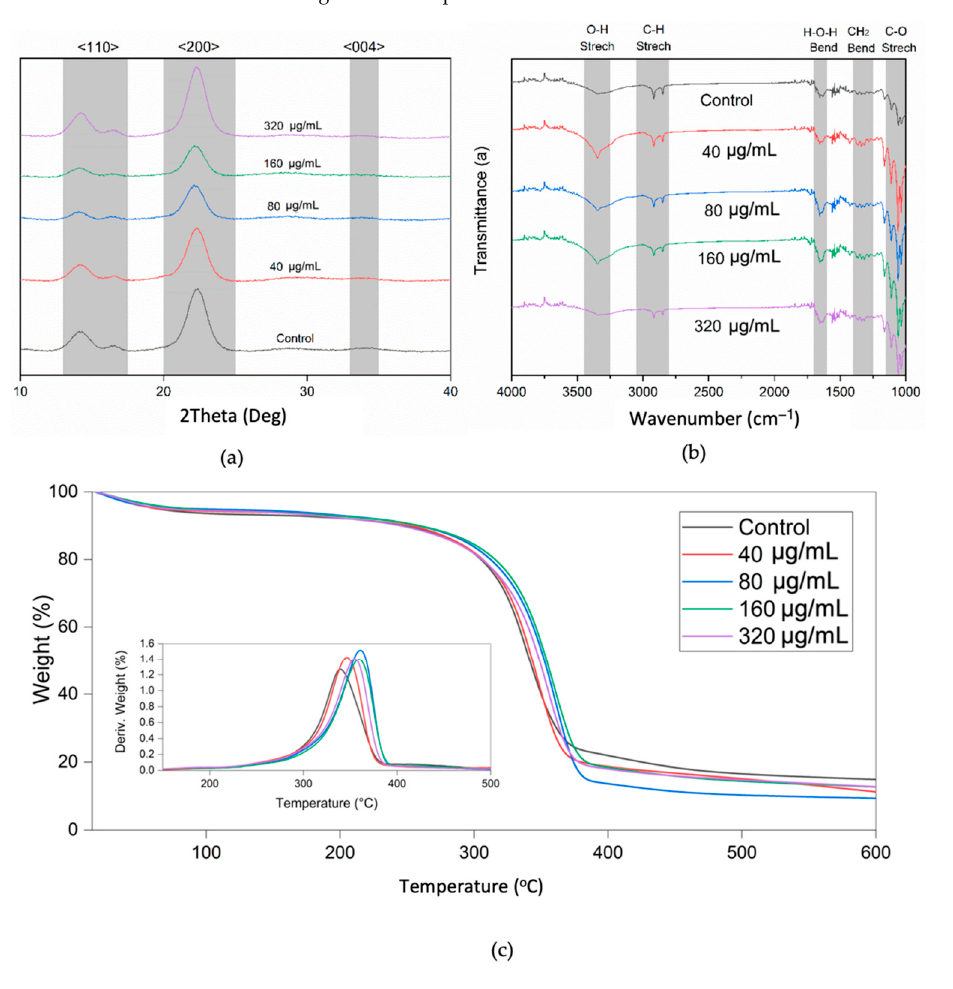
Figure 4. The material properties of produced BCs. ( a ) XRD, ( b ) FTIR, and ( c ) TGA